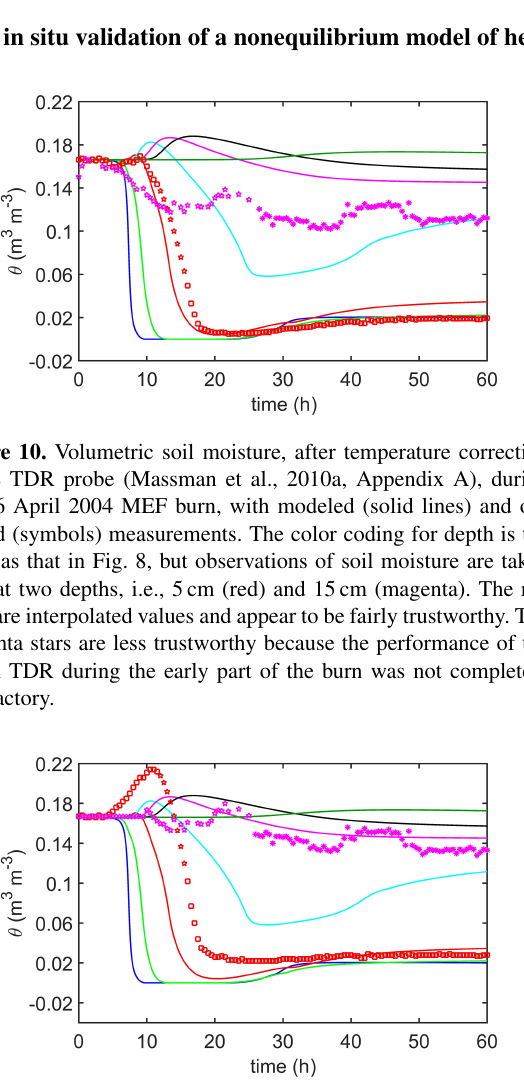
Figure 11. Volumetric soil moisture, without temperature correc- tion to the TDR (Massman et al., 2010a, Appendix A) during the 26 April 2004 MEF burn, with modeled (solid lines) and observed (symbols) measurements. The color coding for depth is the same as that in Fig. 8, but observations of soil moisture are taken only at two depths, i.e., 5cm (red) and 15cm (magenta). The red stars are in- terpolated values and appear to be fairly trustworthy. The magenta stars are less trustworthy because the performance of the 15cm TDR during the early part of the burn was not completely satis-